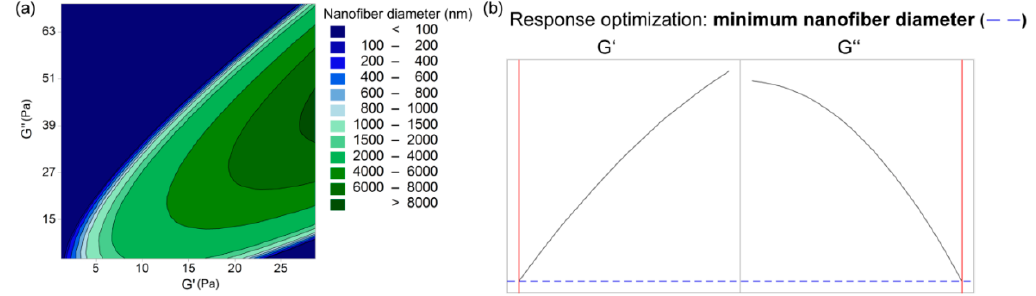
Figure 10. ( a ) contour plot of the resulting nanofiber diameter as a function of the polymer-blend solution storage (G (cid:48) ) and loss (G (cid:48)(cid:48) ) moduli; ( b ) response optimization plots of the nanofiber diameter as a function of the polymer-blend solution storage and loss